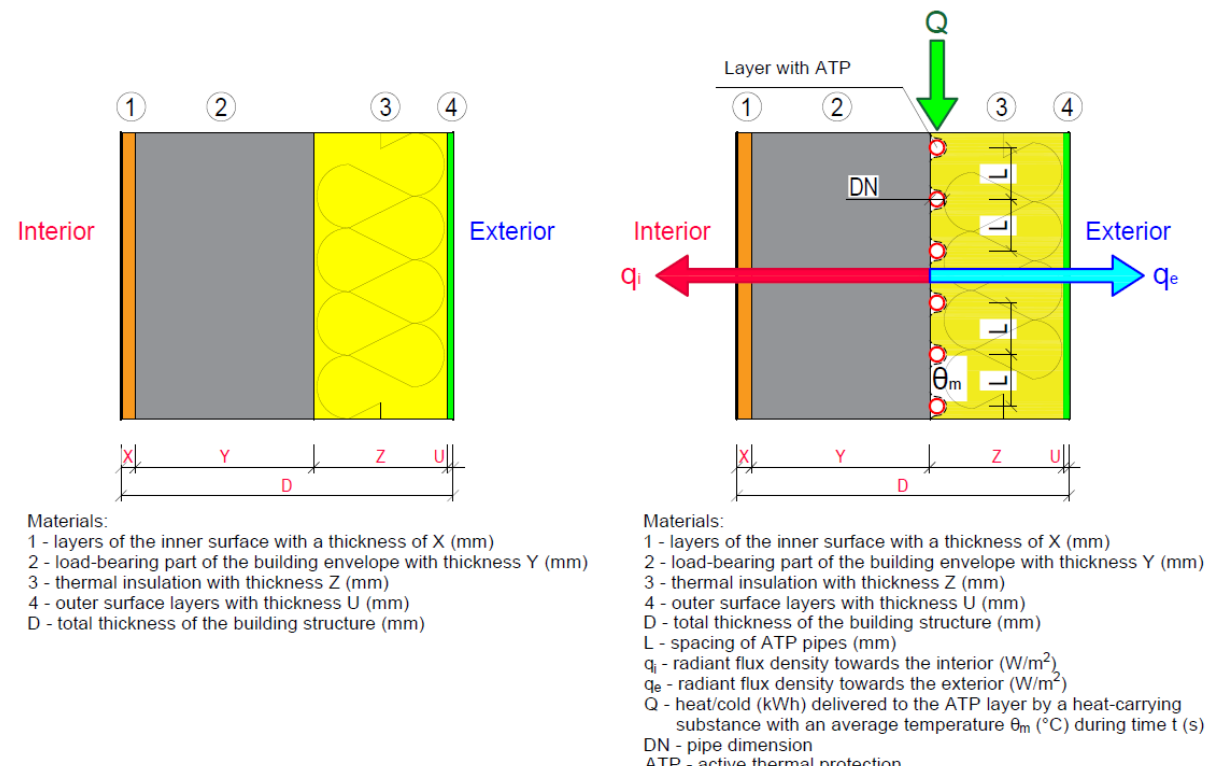
Figure 41. Mathematical-physical model for the calculation of conventional and dynamic ther- mal